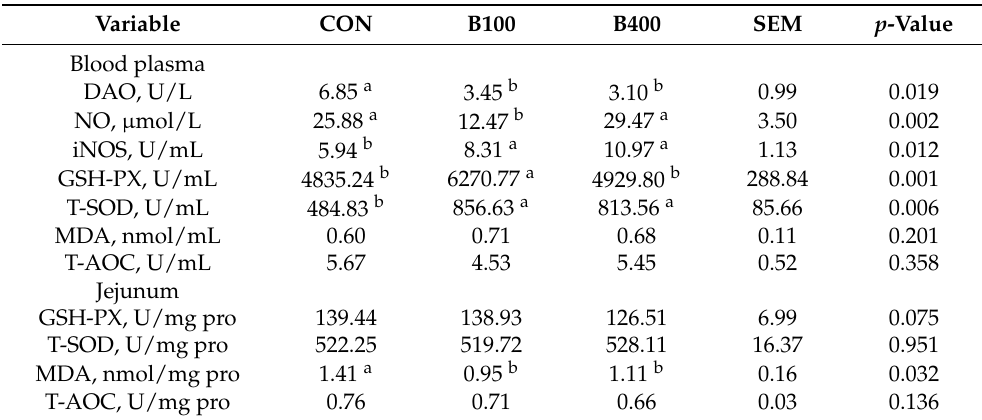
Table 6. Effects of dietary supplementation with bilberry extract on antioxidant activity of yellow- feathered chickens at the age of 63 d 1